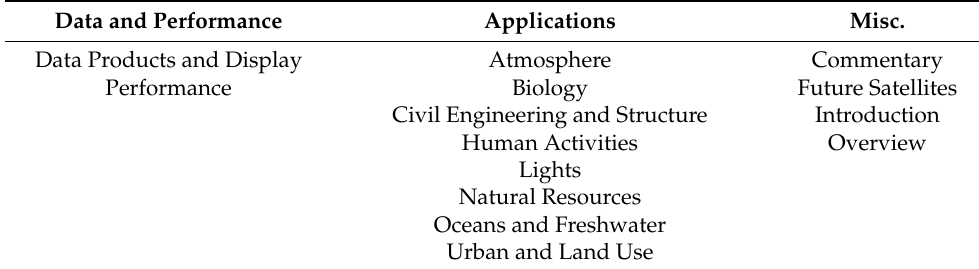
Table 1. Main tagging categories and